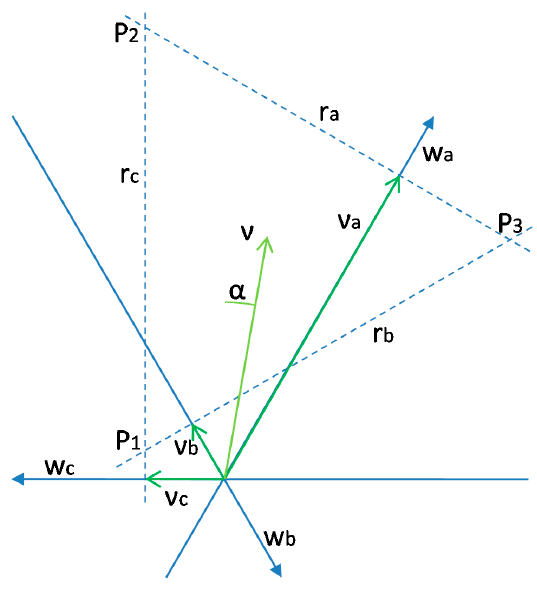
Figure 16. Graphic diagram to solve the kinematic of mobile robot based on use the projections of the velocity vectors of each wheel.